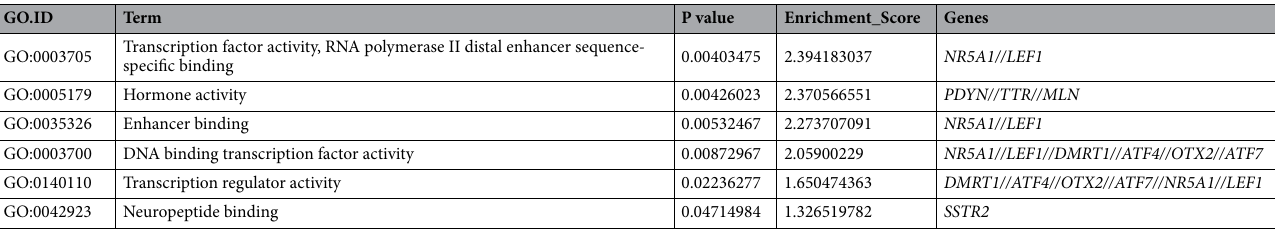
Table 8. The molecular functions with up-regulated gene enrichment scores.